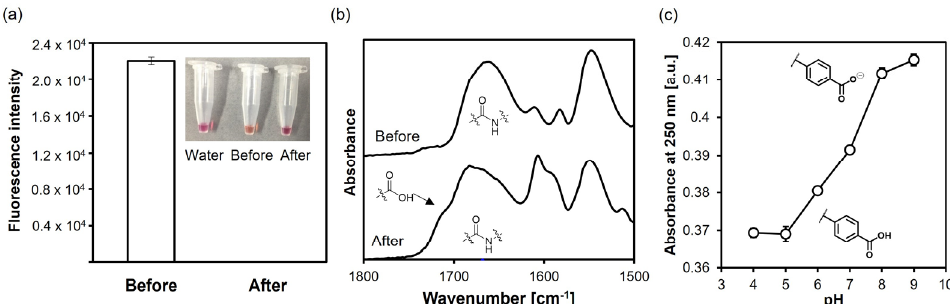
Figure 2. Modification of BNPs with 4-iodo-benzoic acid via aqueous Suzuki–Miyaura coupling reaction (NP-1). ( a ) PBA groups before and after the reaction as detected by the alizarin red S assay. The amount of the PBA group was determined by the formation of fluorescent PBA–alizarin red S complex. The samples were mixed with alizarin red S and the fluorescence intensity ( λ ex = 485 nm, λ em = 616 nm) was measured. Insert: Photos of alizarin red S solutions. Left: without BNP. Middle: with BNP before reaction. Right: with BNP after reaction. ( b ) IR spectra of lyophilized BNPs before and after the Suzuki–Miyaura reaction. ( c ) pH ‐ dependent change in absorbance at 250 nm of NP ‐ 1. n = 3.